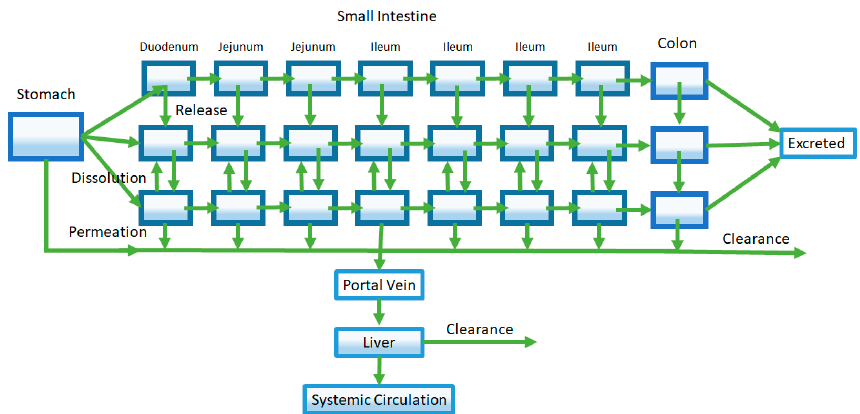
Figure 4. The representative Advanced Compartment Absorption and Transit (ACAT) model pictured here is an extension of the CAT model. Shown in this representative ACAT model, additional compartments are added to characterize features such as stomach and colon absorption, drug release from formulation, and first-pass metabolism from the liver and the gut (shown by the Clearance